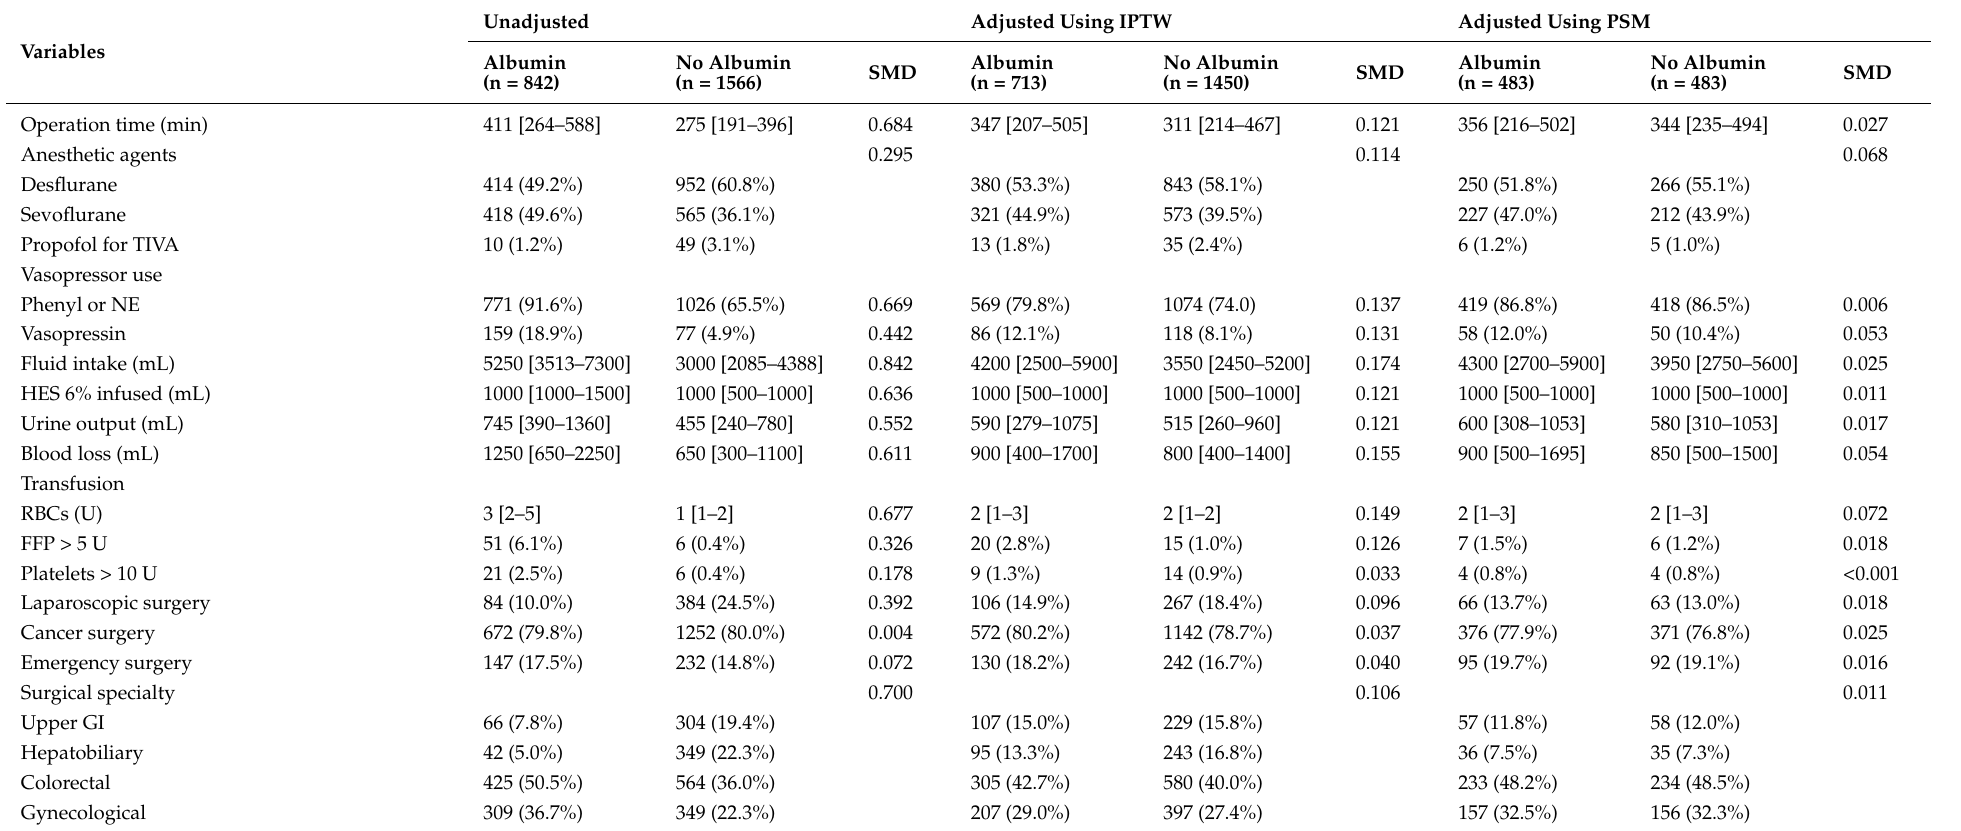
Table 2. Intraoperative characteristics in the unadjusted and adjusted